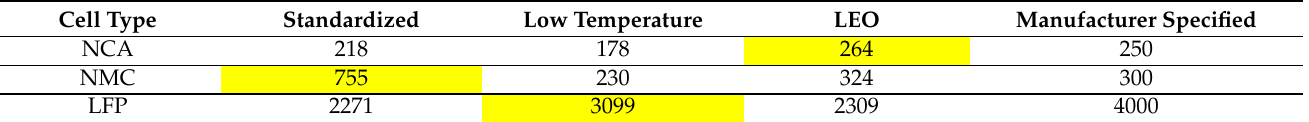
Table 4. Equivalent cycles of initial measured coulombic capacity to degrade to 80% discharge coulombic capacity for each cell type in all three conditions, with manufacturer specified cycle life reproduced for clarity. Highest experimental equivalent cycle life is